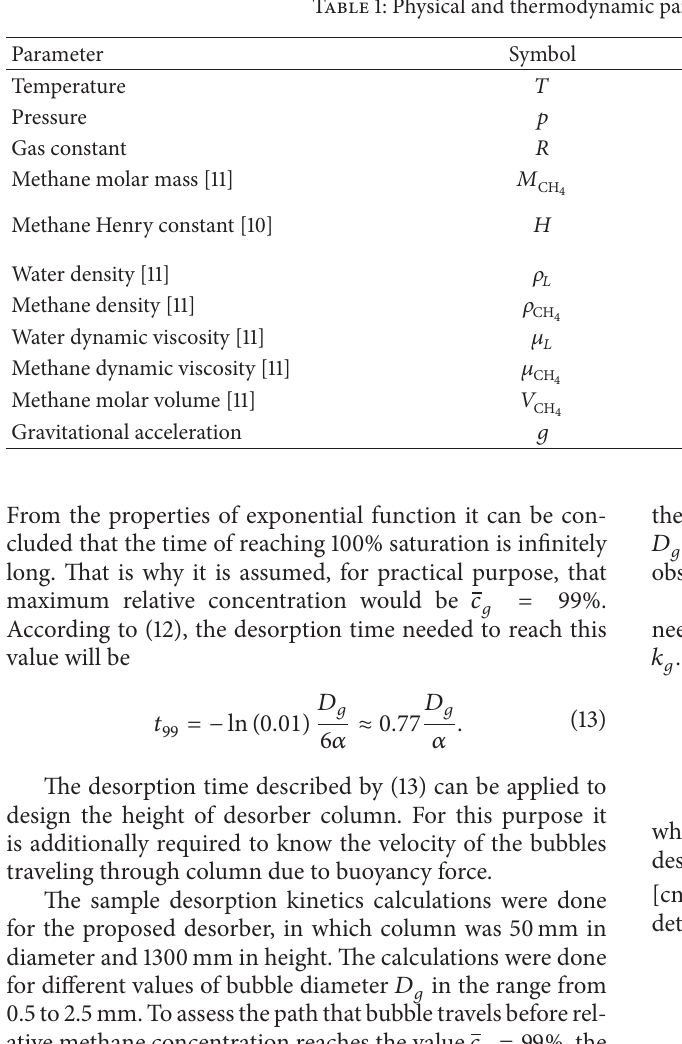
Table 1: Physical and thermodynamic parameters used in